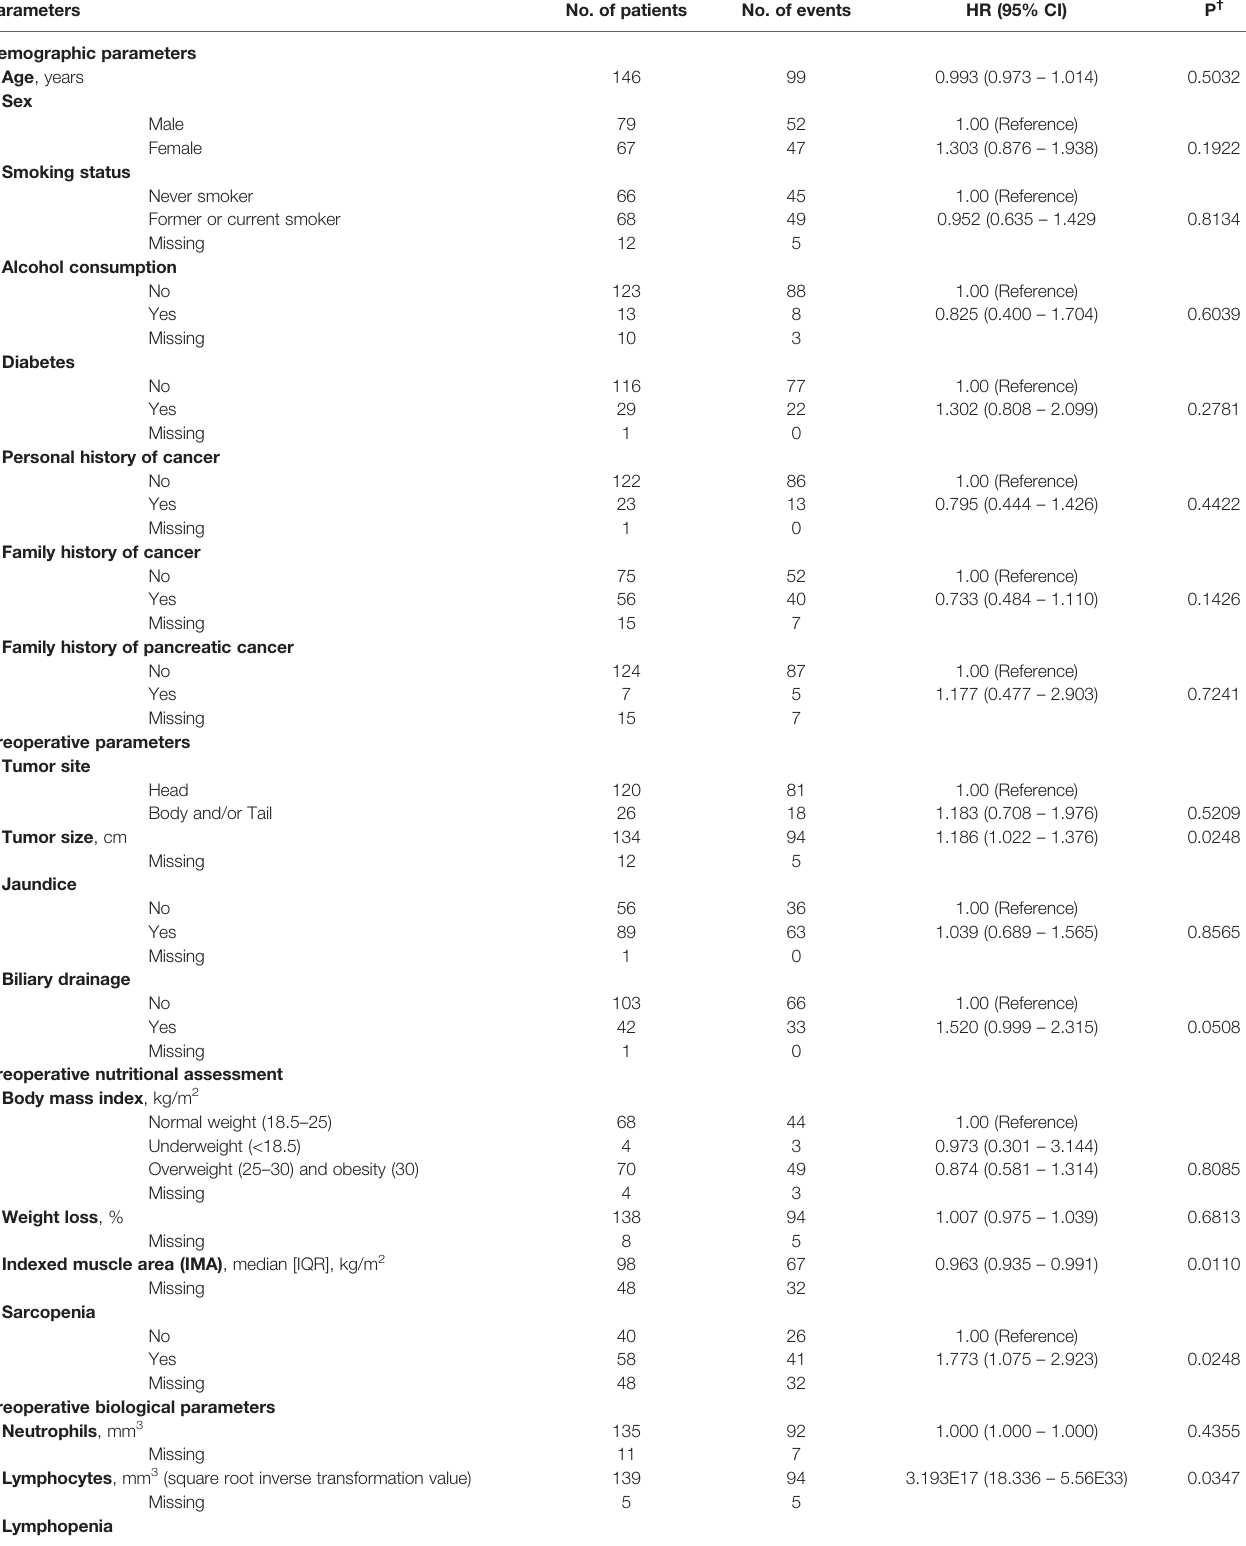
TABLE 2 | Prognostic factors associated with relapse-free survival in univariate